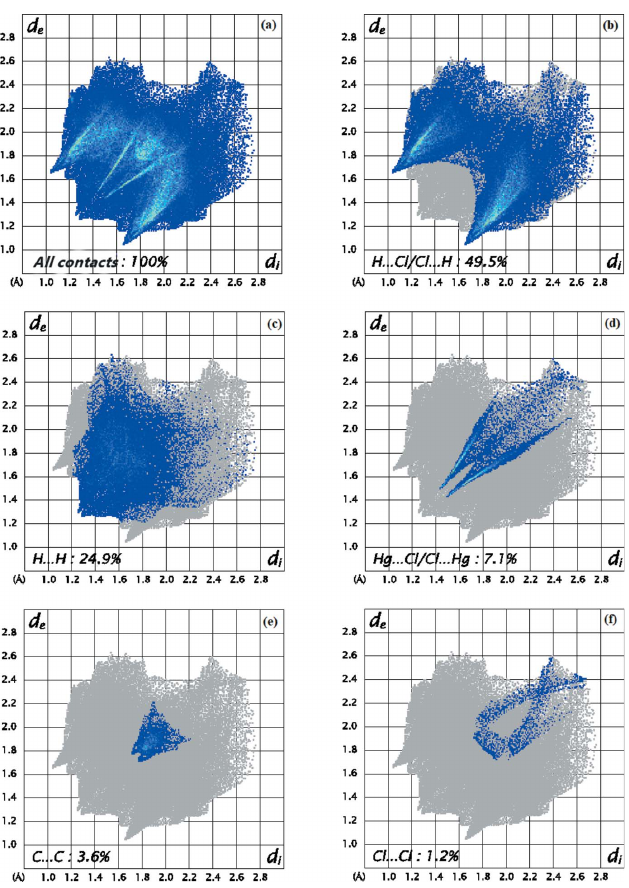
Figure 11 Full two-dimensional fingerprint plots for (I), showing ( a ) all interactions, and delineated into ( b ) H (cid:3)(cid:3)(cid:3) Cl/Cl (cid:3)(cid:3)(cid:3) H, ( c ) H (cid:3)(cid:3)(cid:3) H, ( d ) Hg (cid:3)(cid:3)(cid:3) Cl/Cl (cid:3)(cid:3)(cid:3) Hg, ( e ) C (cid:3)(cid:3)(cid:3) C and ( f ) Cl (cid:3)(cid:3)(cid:3) Cl interactions. The d i and d e values are the closest internal and external distances (in A˚ ) from a given point on the Hirshfeld surface.